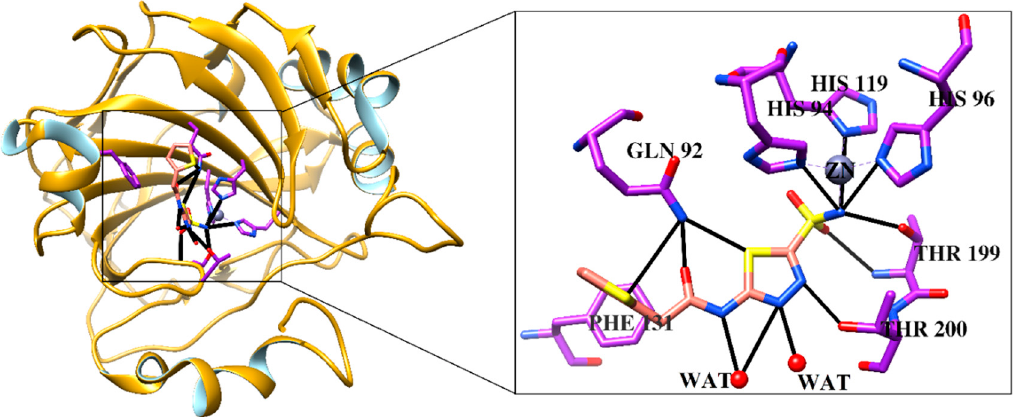
Figure 6. The 3D structural topology of human carbonic anhydrase II is displayed in ribbon form complex with known inhibitor. The active site residues are shown in purple stick model, ligand is depicted in coral sticks, hydrogen bonds are displayed as black lines.